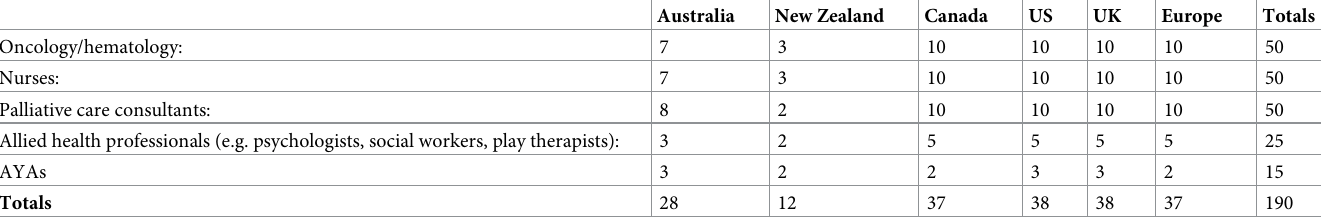
Table 2. Sampling matrix for Round 2 (Questionnaire 1) by discipline and region; planned sample.